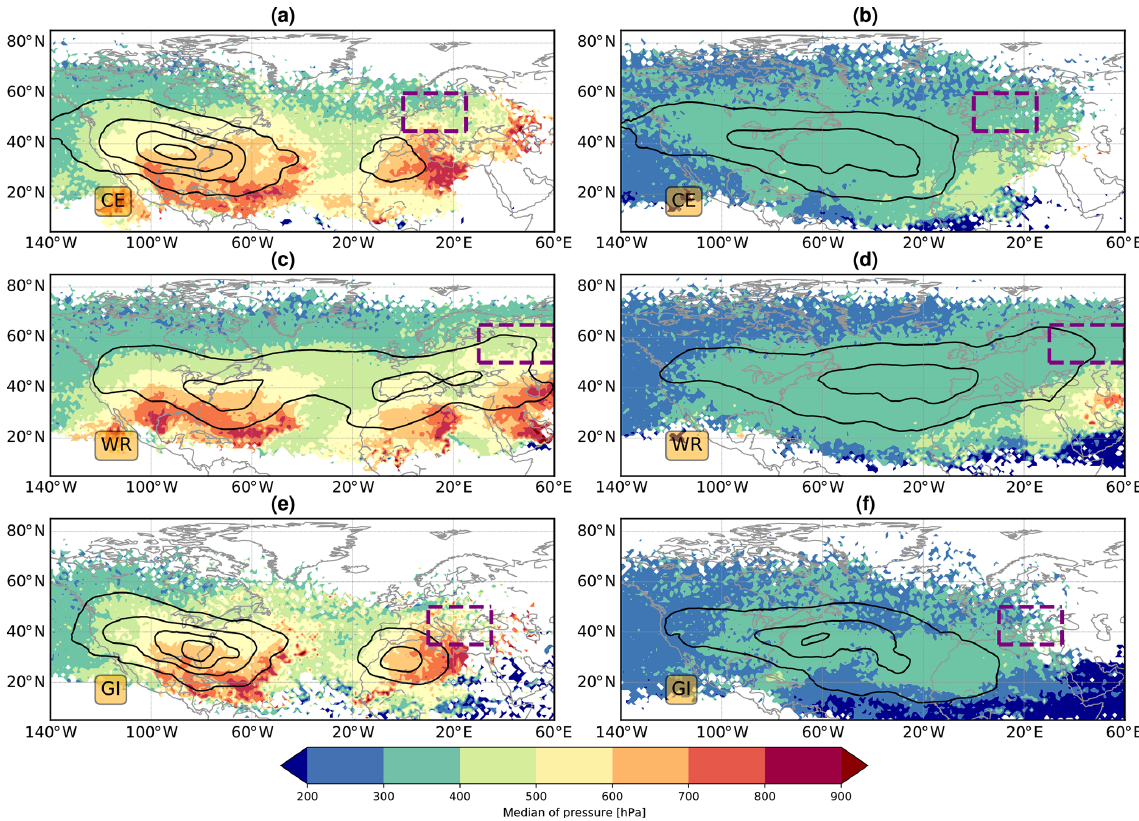
Figure 4. Same as Fig. 3 but for 7d prior to